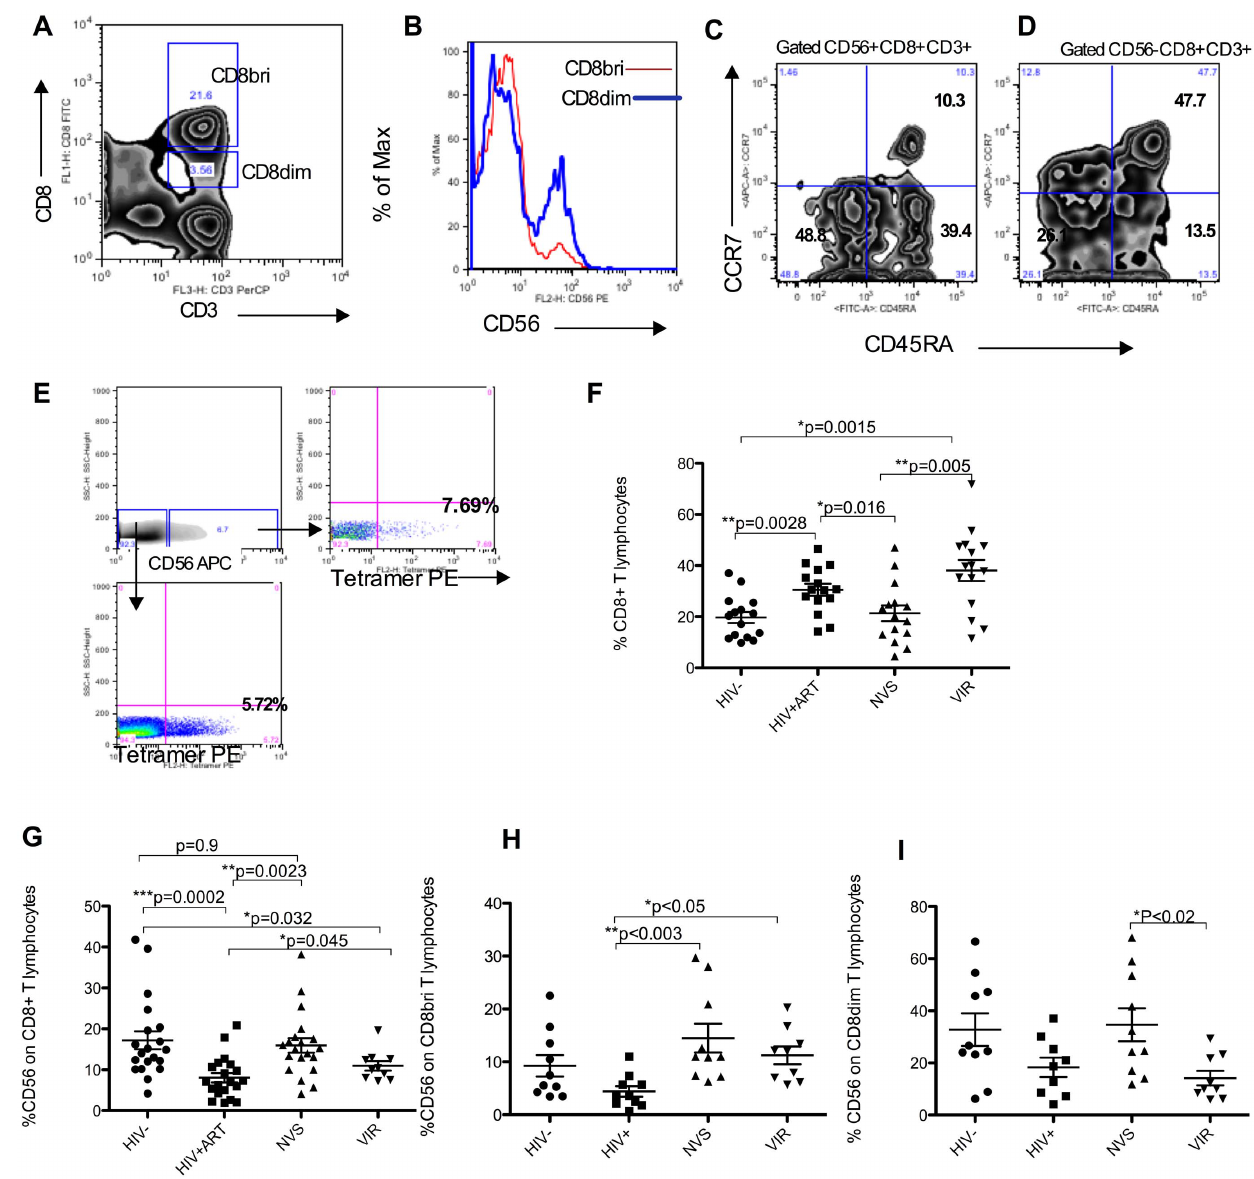
Figure 1. Preserved CD56 + CD8 T lymphocytes in elite controllers. (A, B) Higher expression of CD56 on CD8dim T compared with CD8bright T lymphocytes. (C) Representative samples shows CD56 + CD8 T lymphocytes are mostly effector memory type whereas (D) CD56- CD8 T lymphocytes have a significant subset of naı¨ve and central memory and type cells. (E) Both CD56 + and CD56- subset of CD8 T cells have similar frequency of HIV tetramer binding cells. Cells from an HLAB5701 HIV infected individual were stained with TW10 tetramer. Cells are gated on CD8 + CD3 + lymphocytes. (F) Significantly elevated CD8 T cell frequencies in both ART treated and low viremia (VIR) groups but not in elite controllers (NVS). (G) The frequency of CD56 + CD8 + T lymphocytes is significantly reduced in HIV + ART treated group compared with uninfected controls. NVS (elite controllers) did not show this defect and have normal levels of CD56 expression on CD8 T cells. (H) Analysis of CD8bri (H) or CD8dim (I) populations of T cells show that NVS group has superior levels of CD56 subset among both populations whereas ART group has lowest levels of CD8bri cells expressing CD56. VIR group has high frequency of CD56 expressing CD8bri but not CD8dim cells when compared with ART patients. For F-I, Kruksal-Wallis test followed by Dunn’s test for multiple correction was used to analyze the four